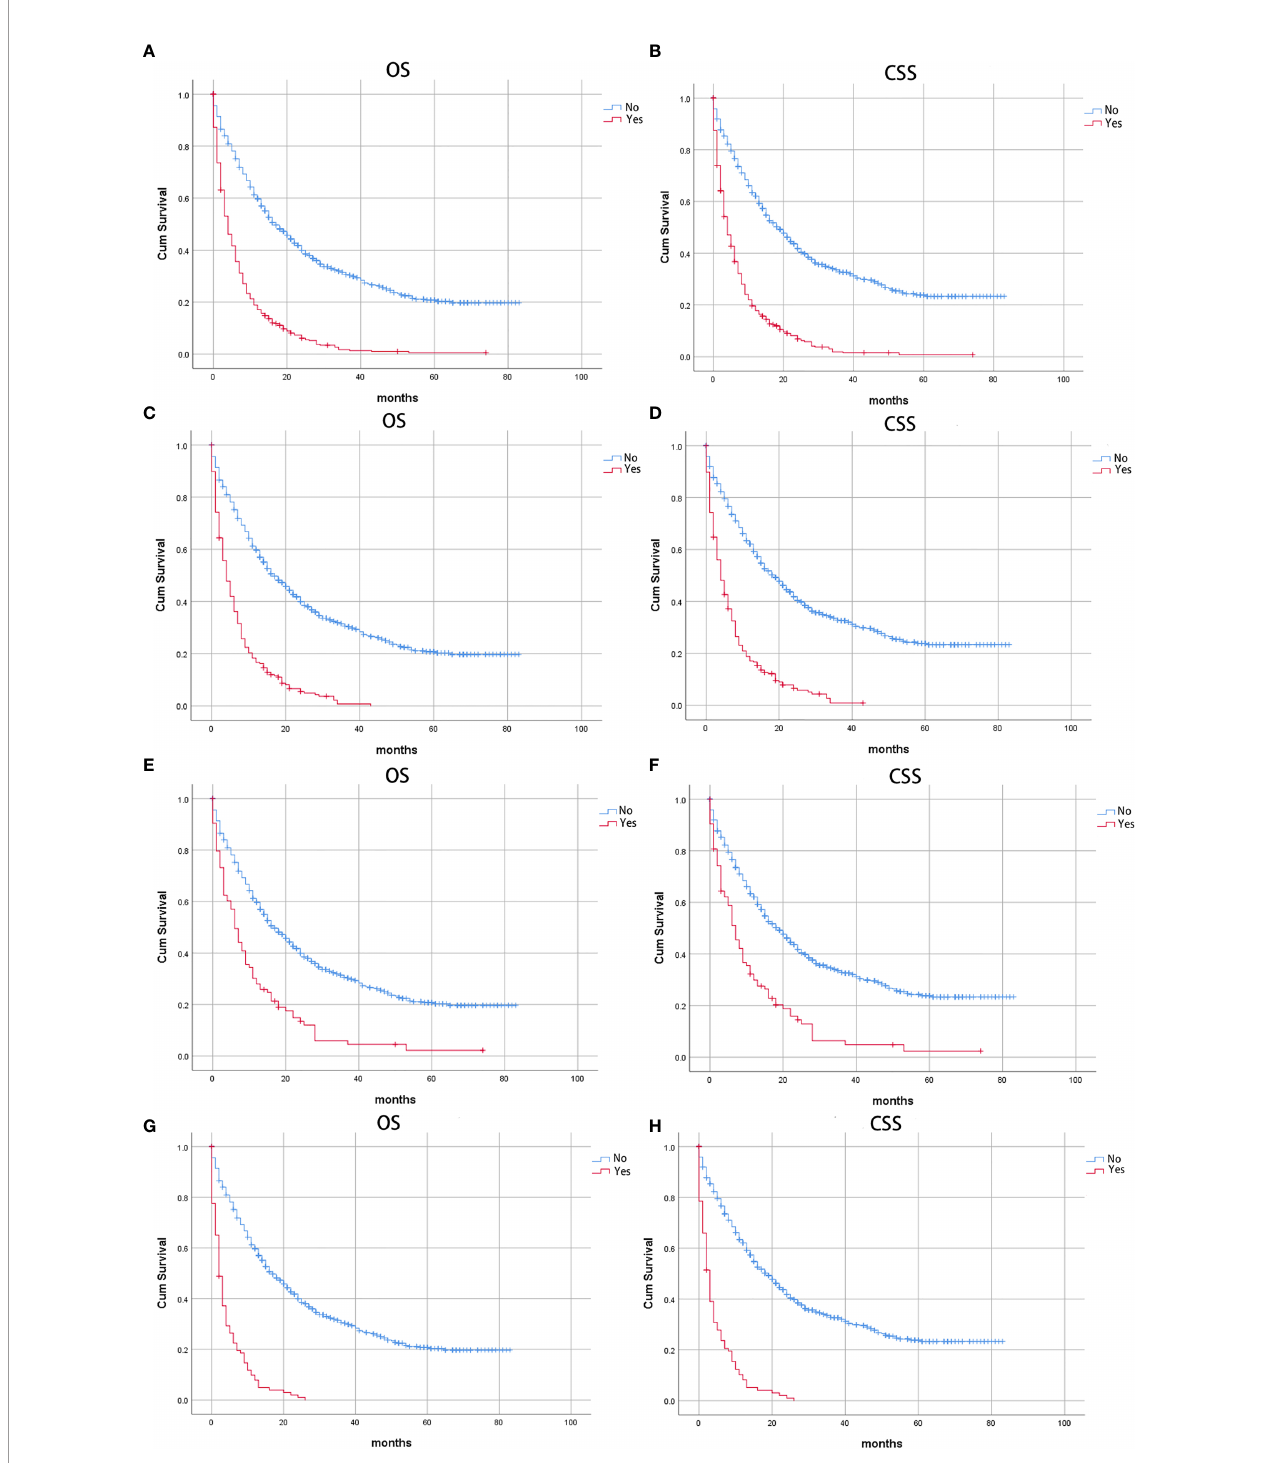
FIGURE 2 | Kaplan-Meier curves of patients with IPMN with associated invasive carcinoma: Strati fi ed by distant metastases (A) Overall survival (OS) and (B) Cancer-speci fi c survival (CSS); strati fi ed by liver metastases, (C) Overall survival (OS) and (D) Cancer-speci fi c survival (CSS); strati fi ed by lung metastases, (E) Overall survival (OS) and (F) Cancer-speci fi c survival (CSS); strati fi ed by multiple metastases, (G) Overall survival (OS); (H) Cancer-speci fi c survival